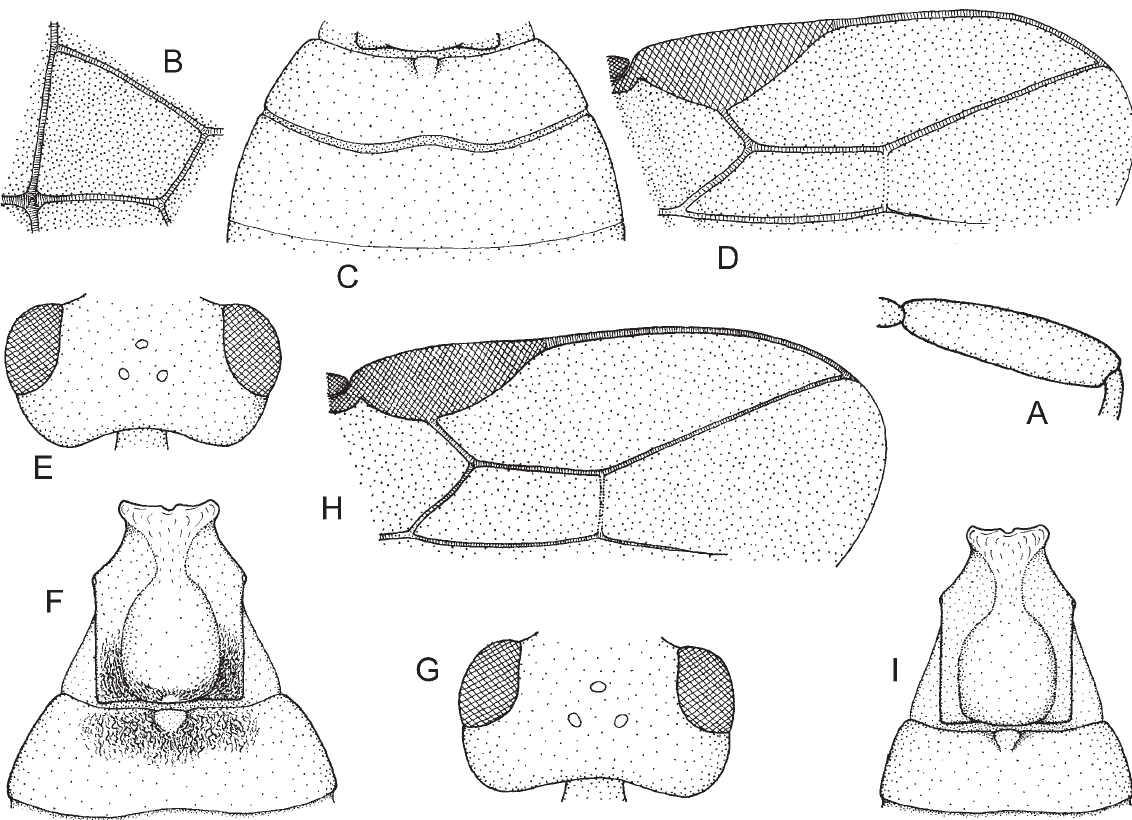
Fig. 2. — A-D . Bracon ( Glabrobracon ) colpophorus Wesmael, 1838. A . Hind femur of ♀ + ♂. B . First discal cell of forewing of ♀. C . Tergites 2-3 of ♀ + ♂. D . Distal part of right forewing of ♂. — E-F . Bracon ( Glabrobracon ) instabilis Marshall, 1885 ♀. E . Head in dorsal view. F . tergites 1-2. — G-I . Bracon ( Glabrobracon ) obscurator Nees, 1811, ♀. G . Head in dorsal view. H . Distal part of right forewing. I . Tergites